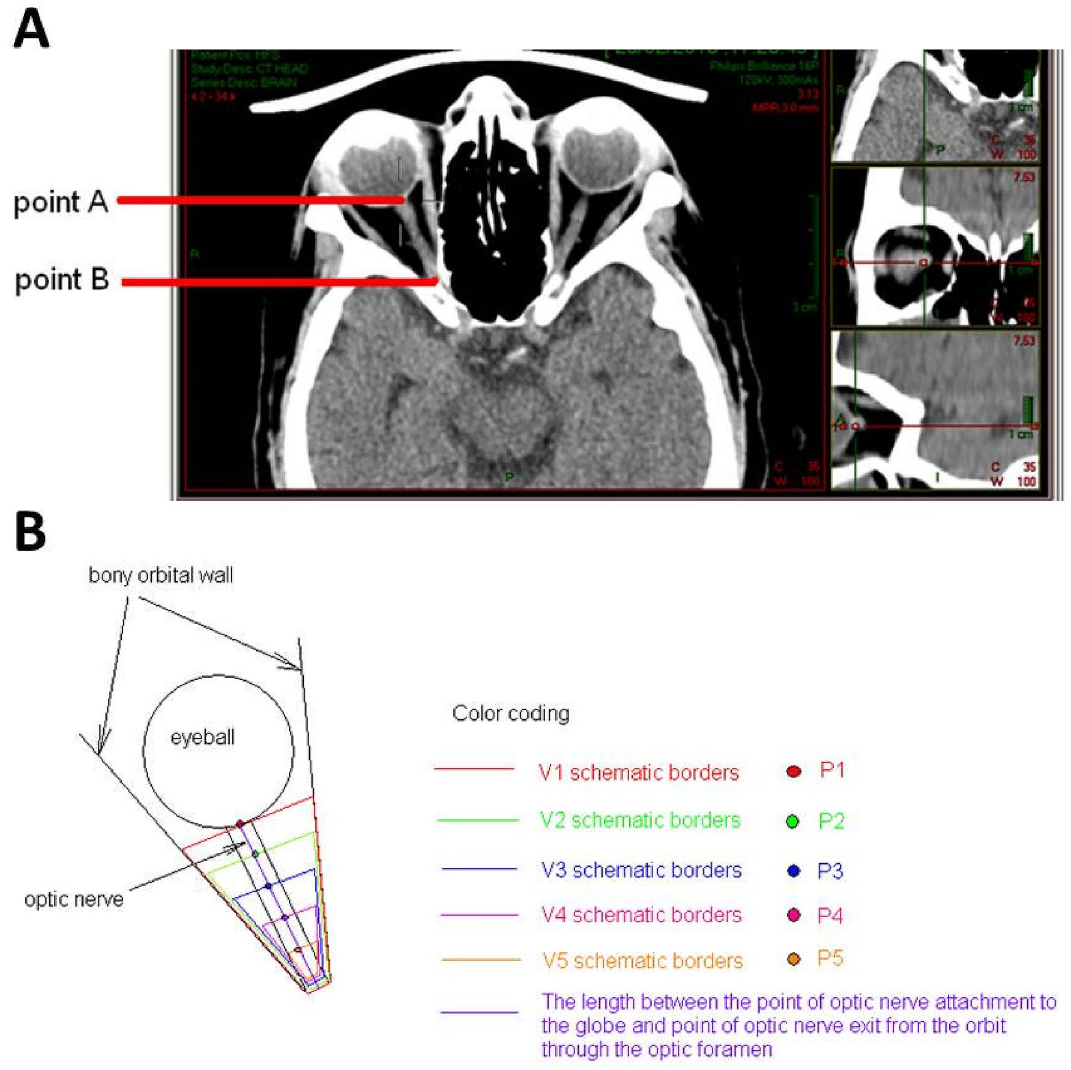
Figure 1. Anatomy and measurements. ( A ) CT scans of orbits in an axial plane with visualization of the intraorbital part of the optic nerve. Point A- the optic nerve exit point at the posterior part of the eyeball. Point B- the optic nerve entry to the optic foramen. ( B ) The measured length was divided into five equal segments designated by points P1to P5 . The total volume V1 was calculated by including all 5 segments, from P1 to the optic foramen. Four additional volume measurements were calculated by subtracting the anterior segment of the previously measured volume. V2 measured the area between P2, and the optic foramen measuring volume at 4/5 of total height V3, V4, andV5 measured volume at 3/5, 2/5,and 1/5 of total height